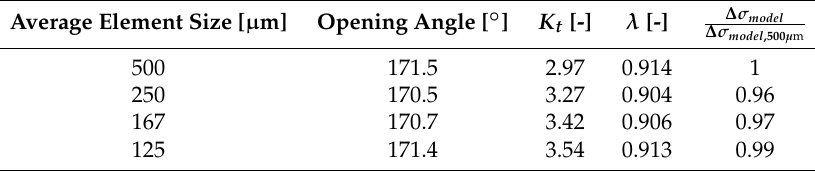
Table 7. Results of the mesh sensitivity study of the specimen #31